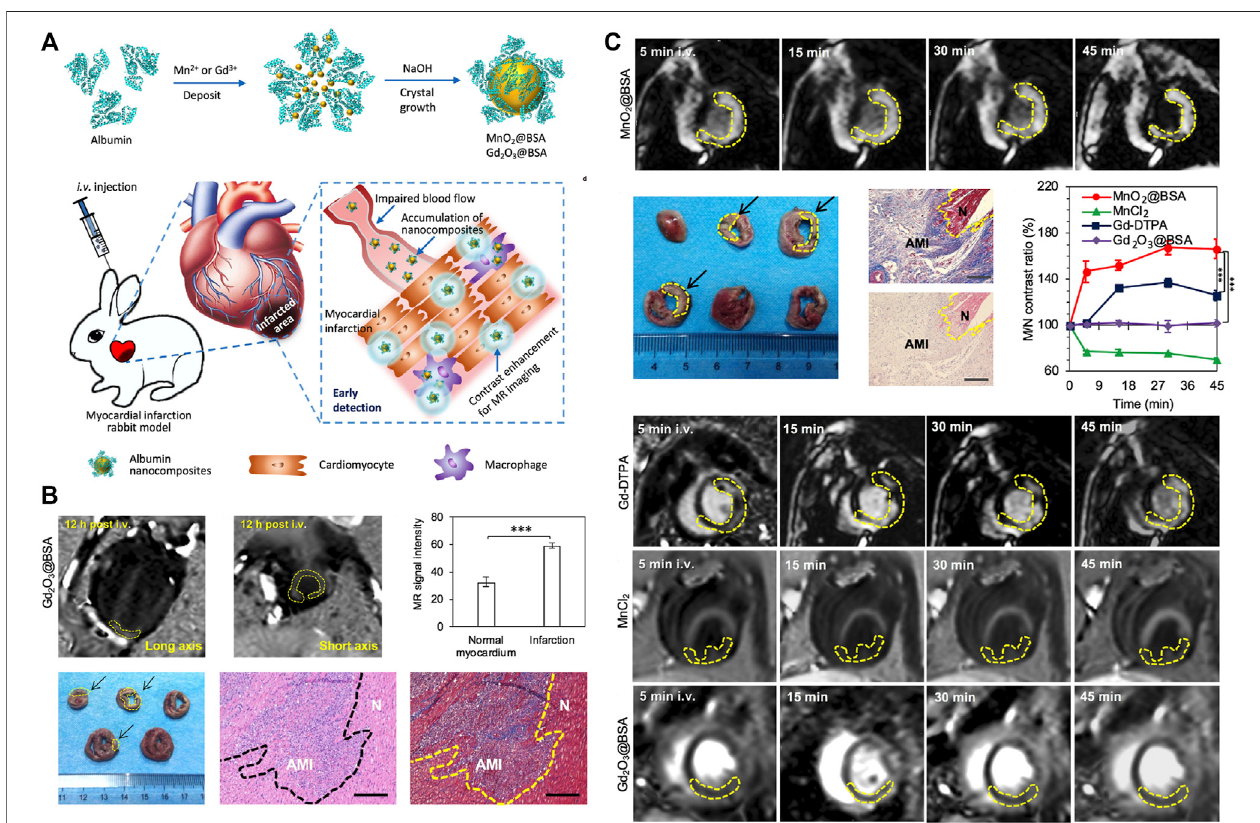
FIGURE 8 | MnO 2 /Gd 2 O 3 nanocomposites used as a contrasting agent for MRI bioimaging modalities for sensitive detection of MI. (A) Schematic illustration of